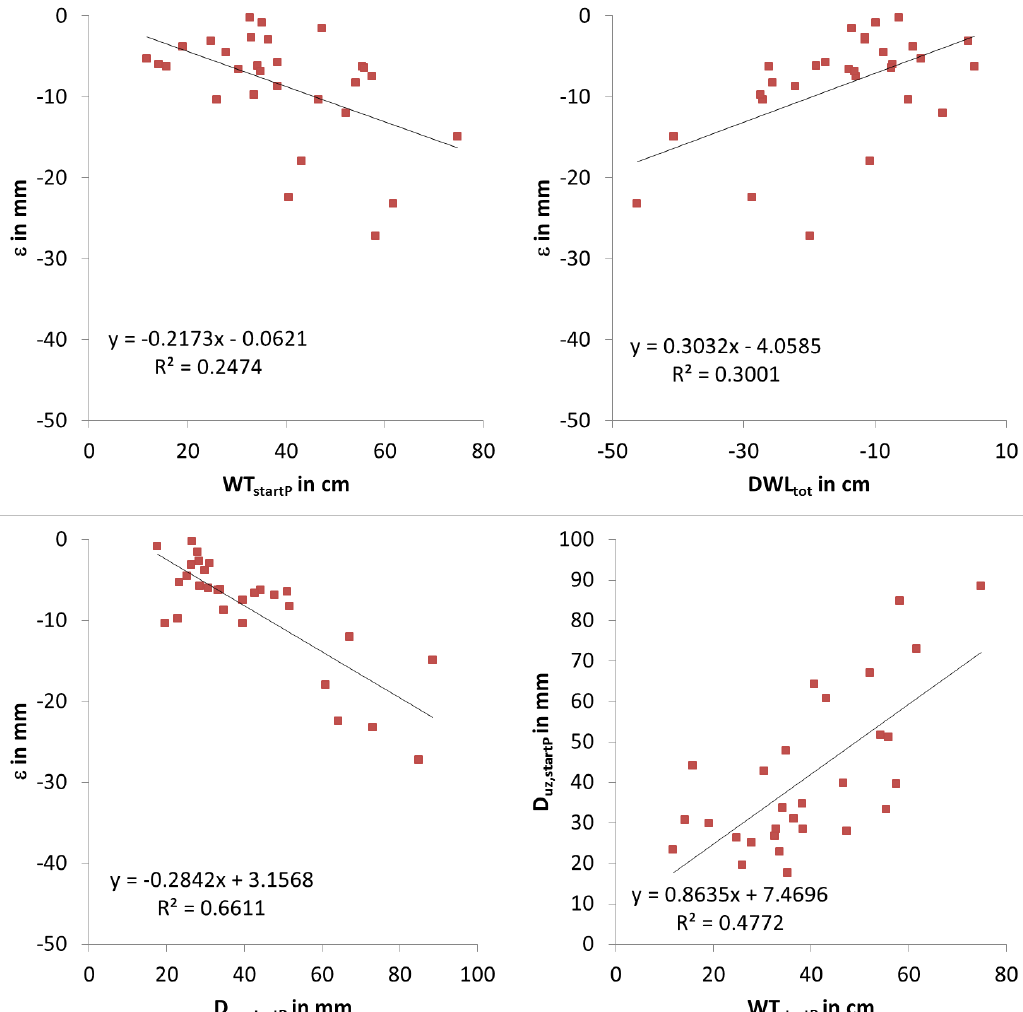
Figure 9. Comparison of the runo ff estimation error due to the quasi-equilibrium assumption ( ε ) with the groundwater level (WT startP , top left ), depletion of the unsaturated zone at t startP (D uz,startP , bottom left ) and the ditch water table during t tot ( ∆ WL tot , top right ). The relationship between the thickness of the unsaturated zone (WT startP ) and depletion of the unsaturated zone (D uz,startP ) is shown at the bottom right . All correlations are significant (p > 0.01).